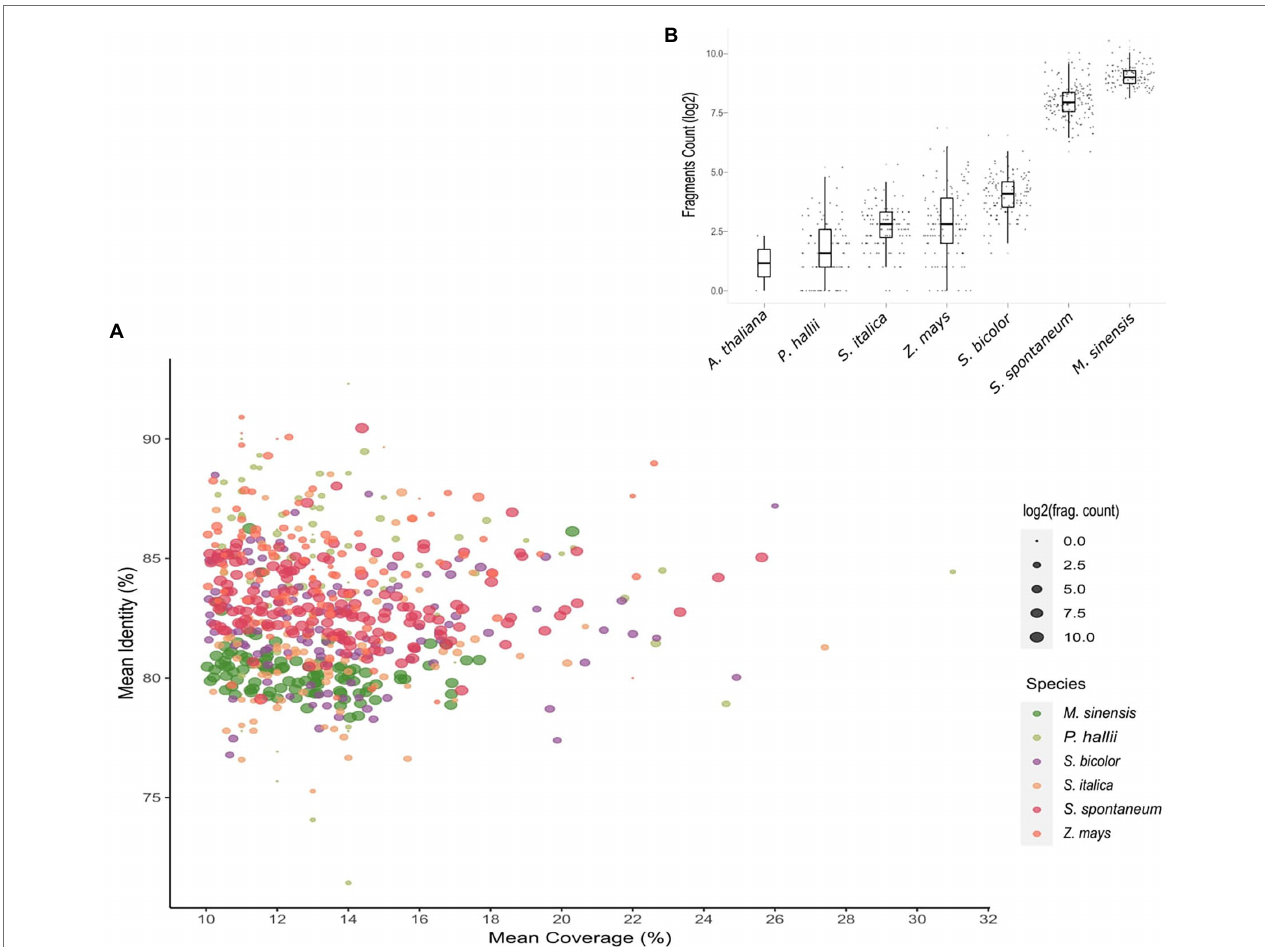
FIGURE 1 | Evidence of orphan gene (OG) vestiges within grass genomes. (A) Scatterplot showing the average percentage identity and coverage of each OG in six grass species. Each dot represents an individual OG. The dot sizes represent the number of fragments of each sugarcane OG in other grass species. The number of fragments of each OG in the focal species is also shown in the bar plot (B)